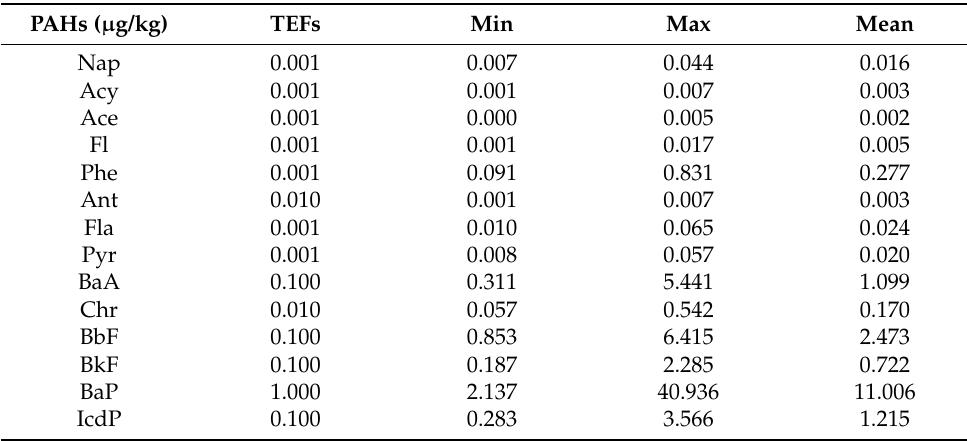
Table 6. Toxic equivalence concentration (TEQ BaP ) of soil